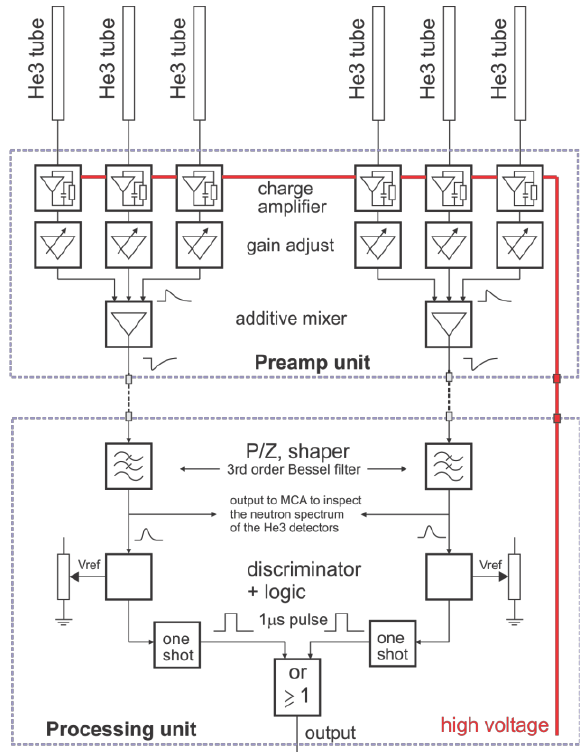
Fig. 1. Diagram of the new electronics.